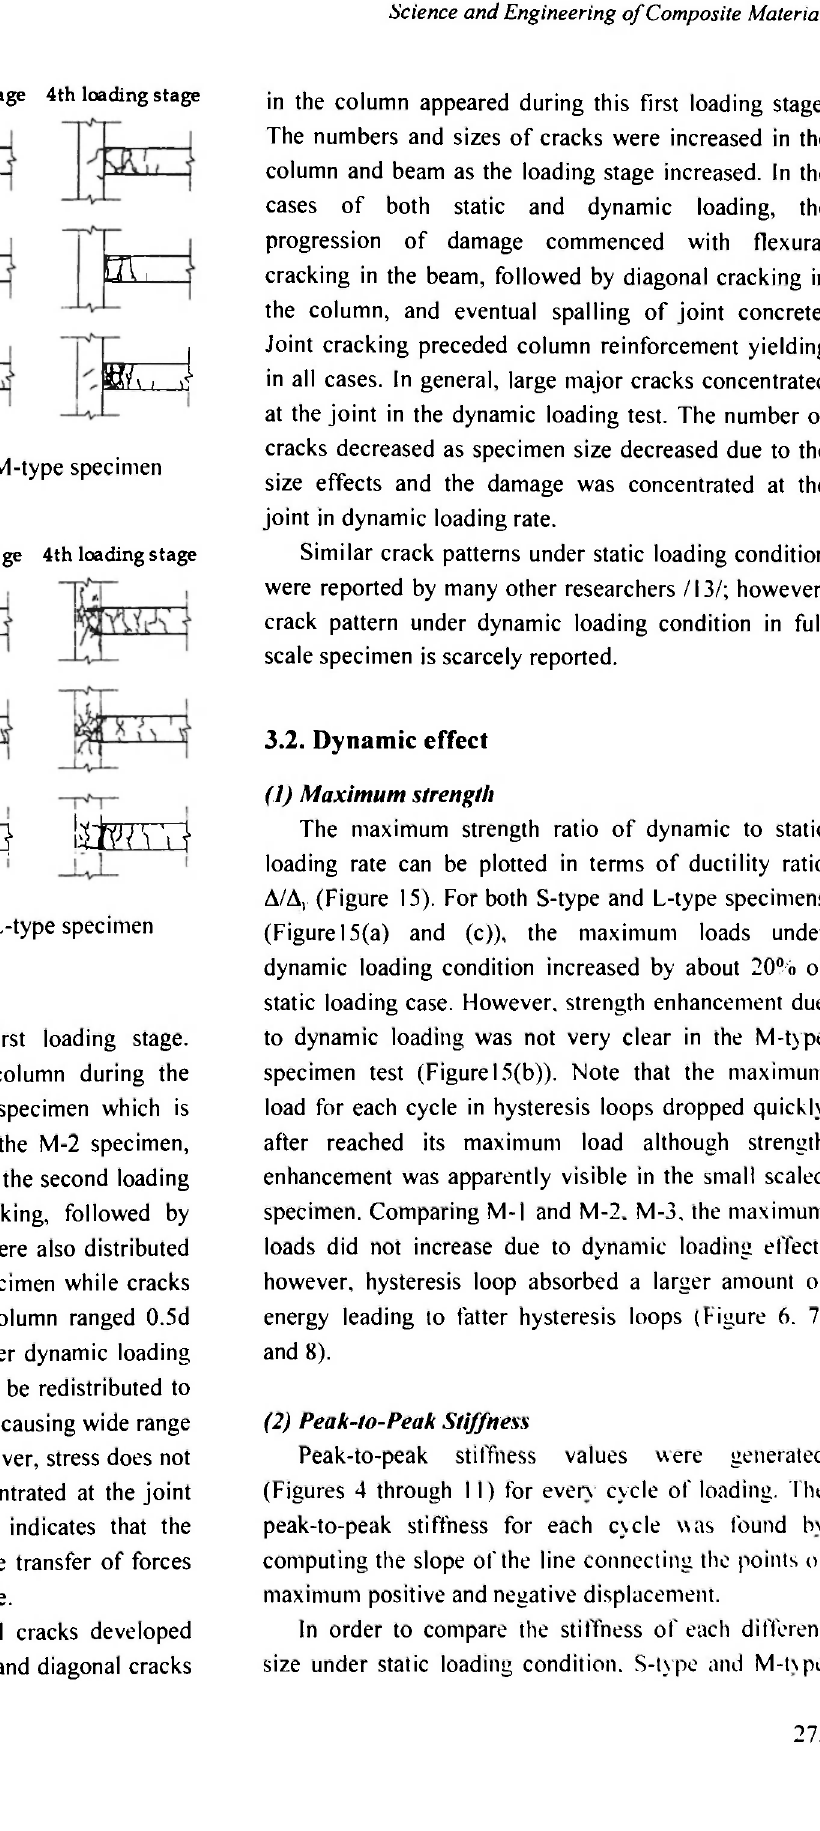
1st loading stage